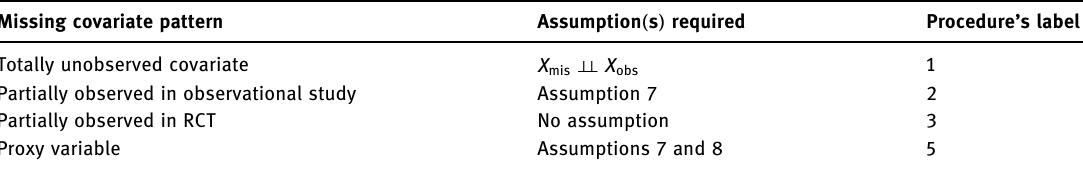
Table 1: Summary of the assumptions and results pointer for all the sensitivity methods according to the missing covariate pattern when the generative outcome is semi - parametric with a linear CATE ( 2 ) Missing covariate